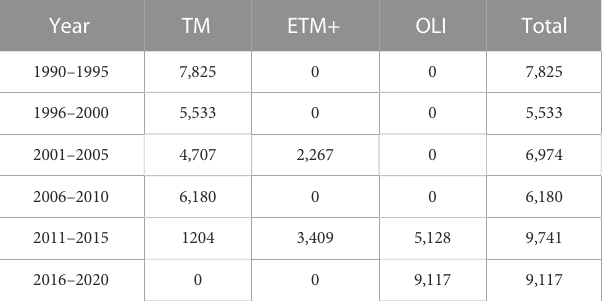
TABLE 1 Statistics of image number in each